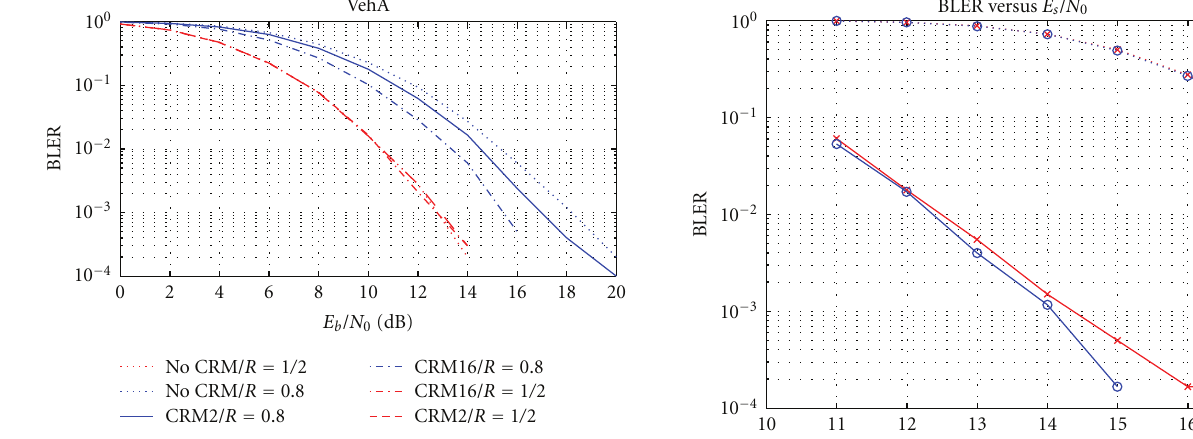
Figure 7: BER performance of SISO LDPC coded transmission with CRM, VehA channel.